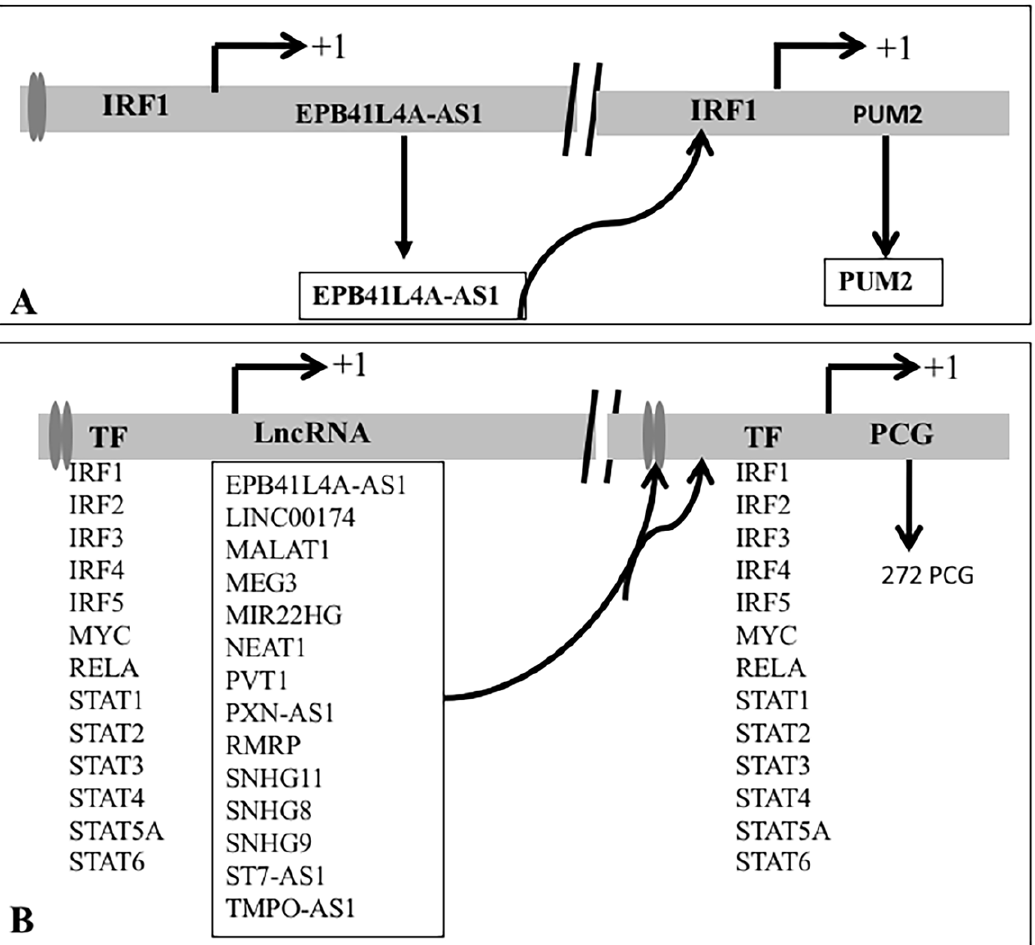
Figure 10. ( A ): Coregulation of PCG by IRF1 and EPB41L4A-AS1. IRF1 binds to DNA (filled horizontal lines) near lncRNA EPB41L4A-AS1 (5q22.1) at +756, +415, +254 of the TSS and PUM2 (2p24.1) at +959 of the TSS (http://rna.sysu.edu.cn/chipbase/, accessed on 1 July 2021). LncRNA EPB41L4A-AS1 also binds to DNA near the PUMA gene (NPInter v4.0, http://bigdata.ibp.ac.cn/npinter4, accessed on 1 July 2021). Solid vertical shapes represent the nucleosome. Vertical lines with a horizontal arrow represent the transcription star sites (TSS). ( B ): At least one of 13 transcription factors could bind to the DNA/chromatin of 14 lncRNA as shown could regulate 14 lncRNA and 272 PCG.